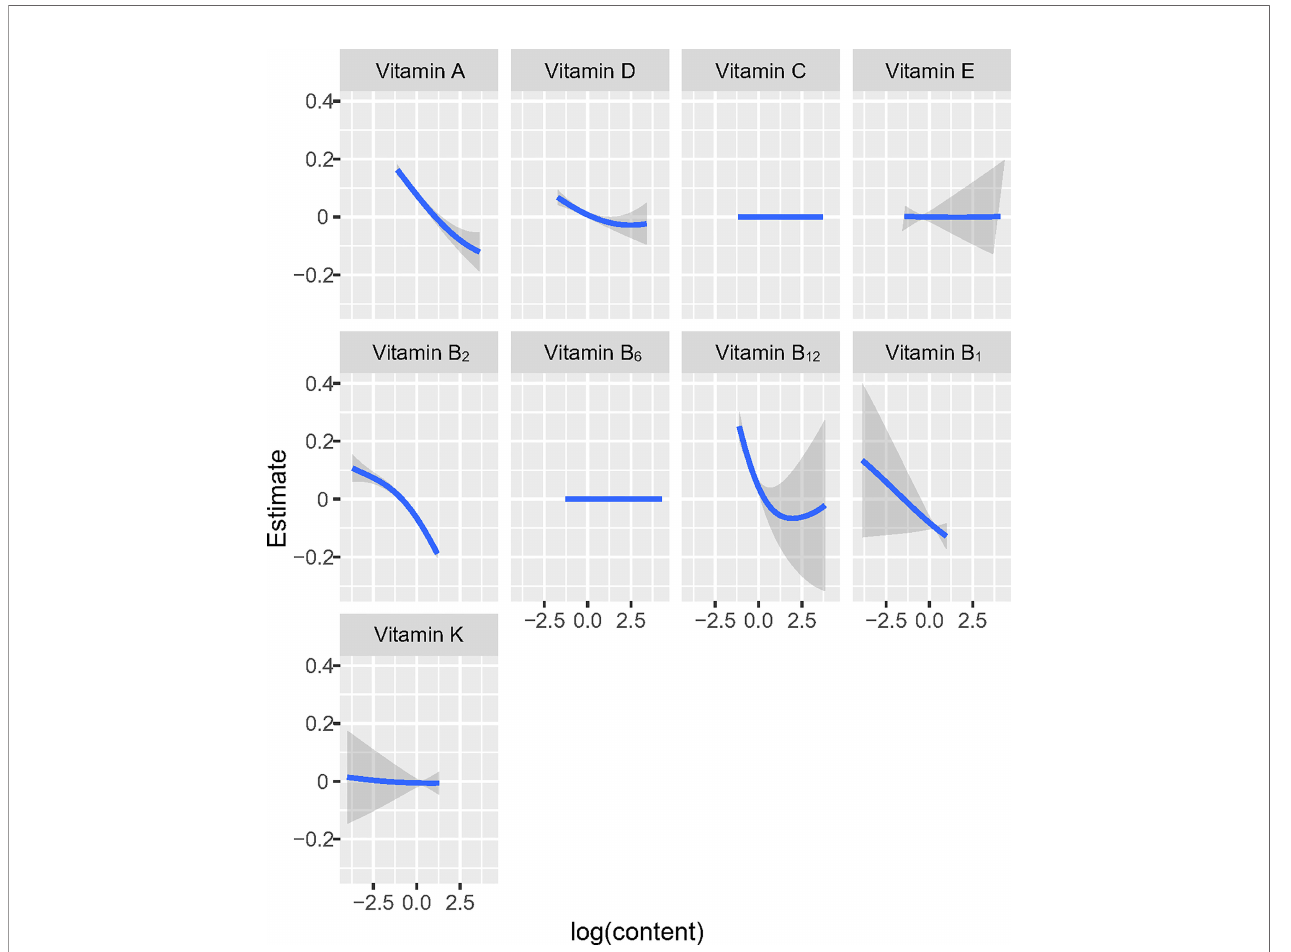
FIGURE 2 | Univariate exposure-response functions and 95% con fi dence interval for association between the intake of single vitamin when the intake of other vitamins is fi xed at the